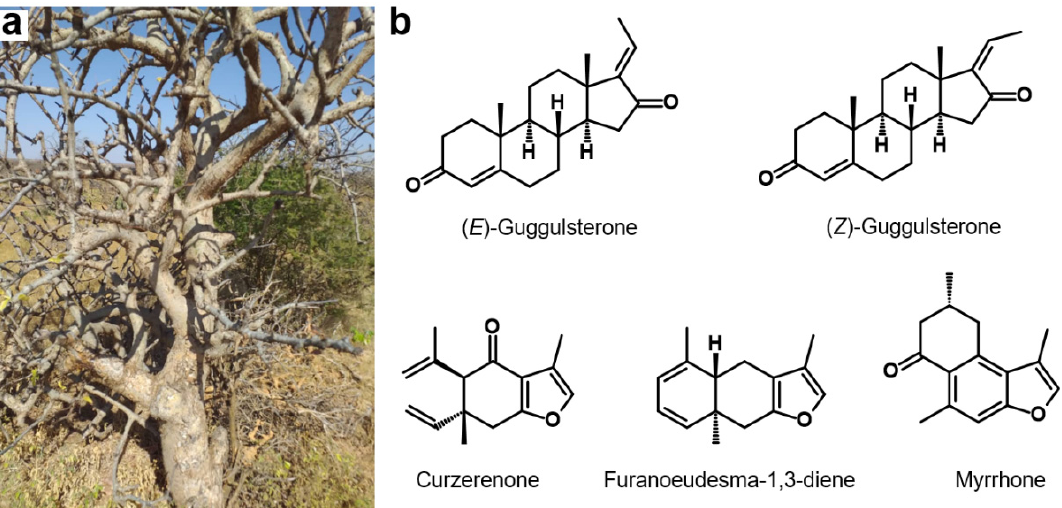
Figure 1. Commiphora tree and lead compounds of the genus Commiphora . ( a ) Tree of the species C. myrrha in Somalia. Picture with friendly permission from Georg Huber. ( b ) Chemical structures of lead compounds found in Commiphora species: phytosteroids ( E )-guggulsterone and ( Z )-guggulsterone and furanosesquiterpenoids curzerenone, furanoeudesma-1,3-diene, and myrrhone. The most known Commiphora oleogum resin is “myrrh”, obtained from trees of C. myrrha (Nees) Engl. (syn. C. molmol Engl.) predominantly growing in Somalia [2]. Further types of well-known Commiphora oleogum resins are “opopanax” (or “bisabol myrrh”) from C. erythraea (Ehrenb.) Engl. and “african opopanax” from C. kataf (Forssk.) Engl., both